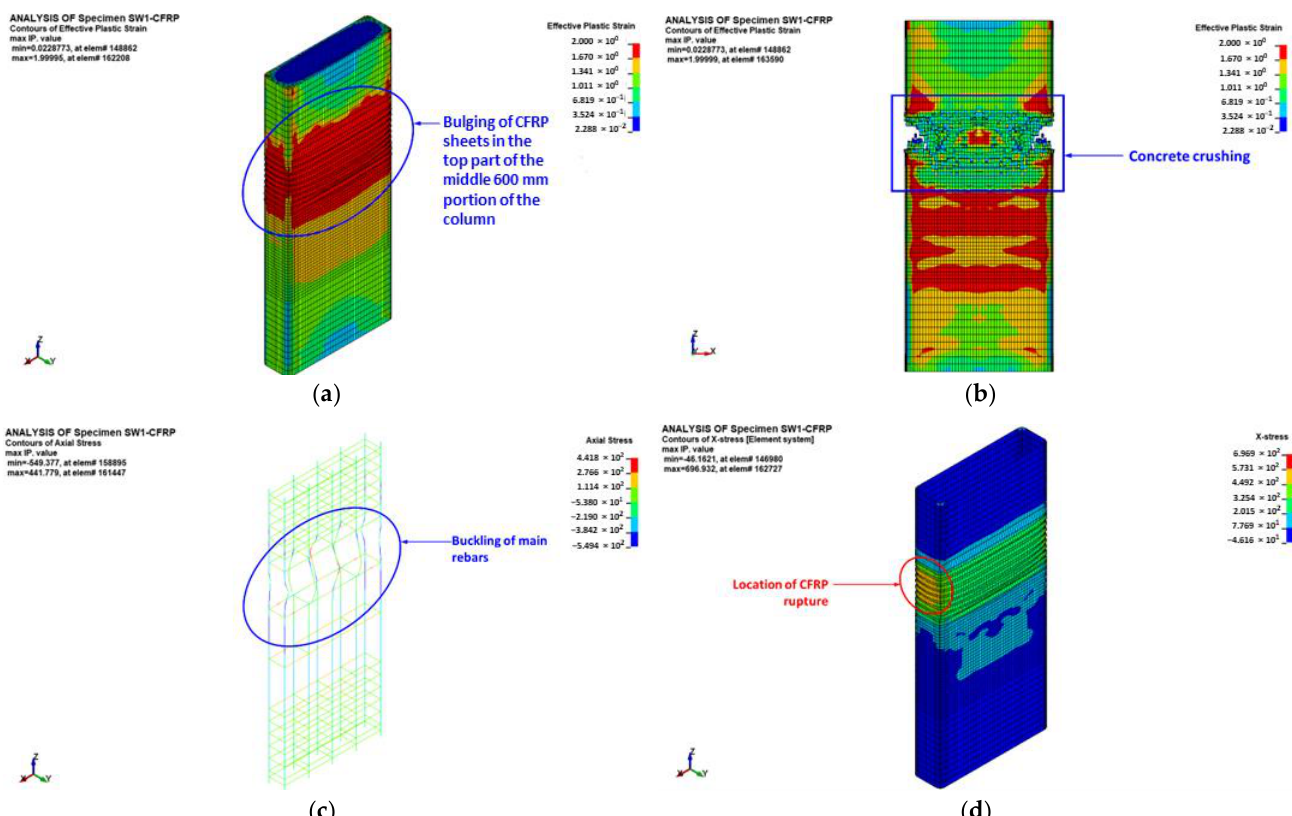
Figure 22. FE mode of failure for strengthened specimen SW1: ( a ) bulging of CFRP sheets at peak load; ( b ) effective plastic stress contours for concrete elements; ( c ) axial stress contours for rebar elements; and ( d ) X-stress contours for shell elements of CFRP sheets.